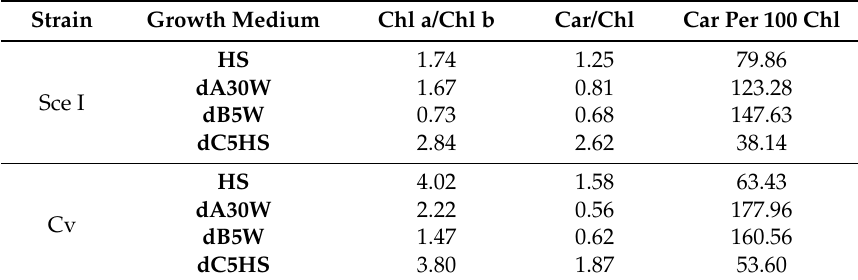
Table 2. HPLC results of pigments extracted from microalgae